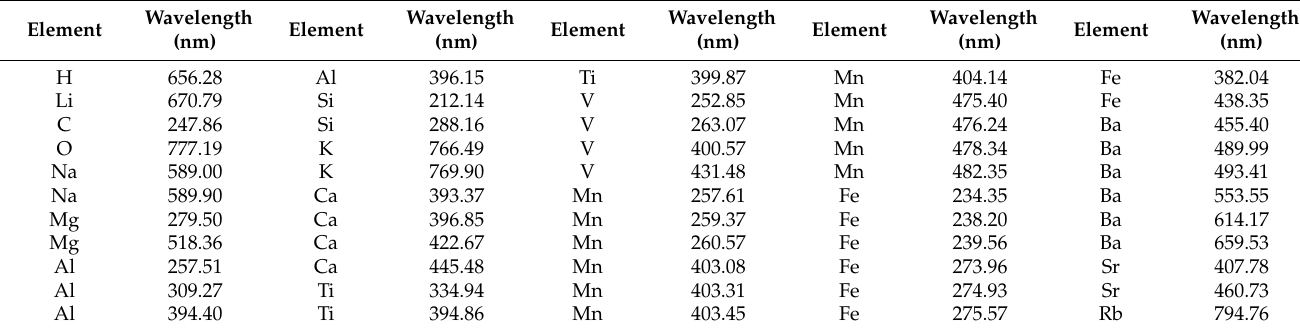
Table 2. Predominant LIBS spectral lines for elements identified in rock varnish across the Mojave Desert. Element